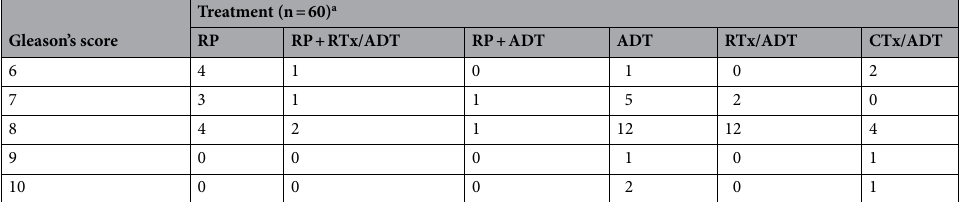
Table 4. Treatments received according to Gleason’s score. RP, radical prostatectomy; ADT, androgen deprivation therapy; RTx, radiation therapy; CTx, chemotherapy (docetaxel); a Only the patients diagnosed with adenocarcinoma are